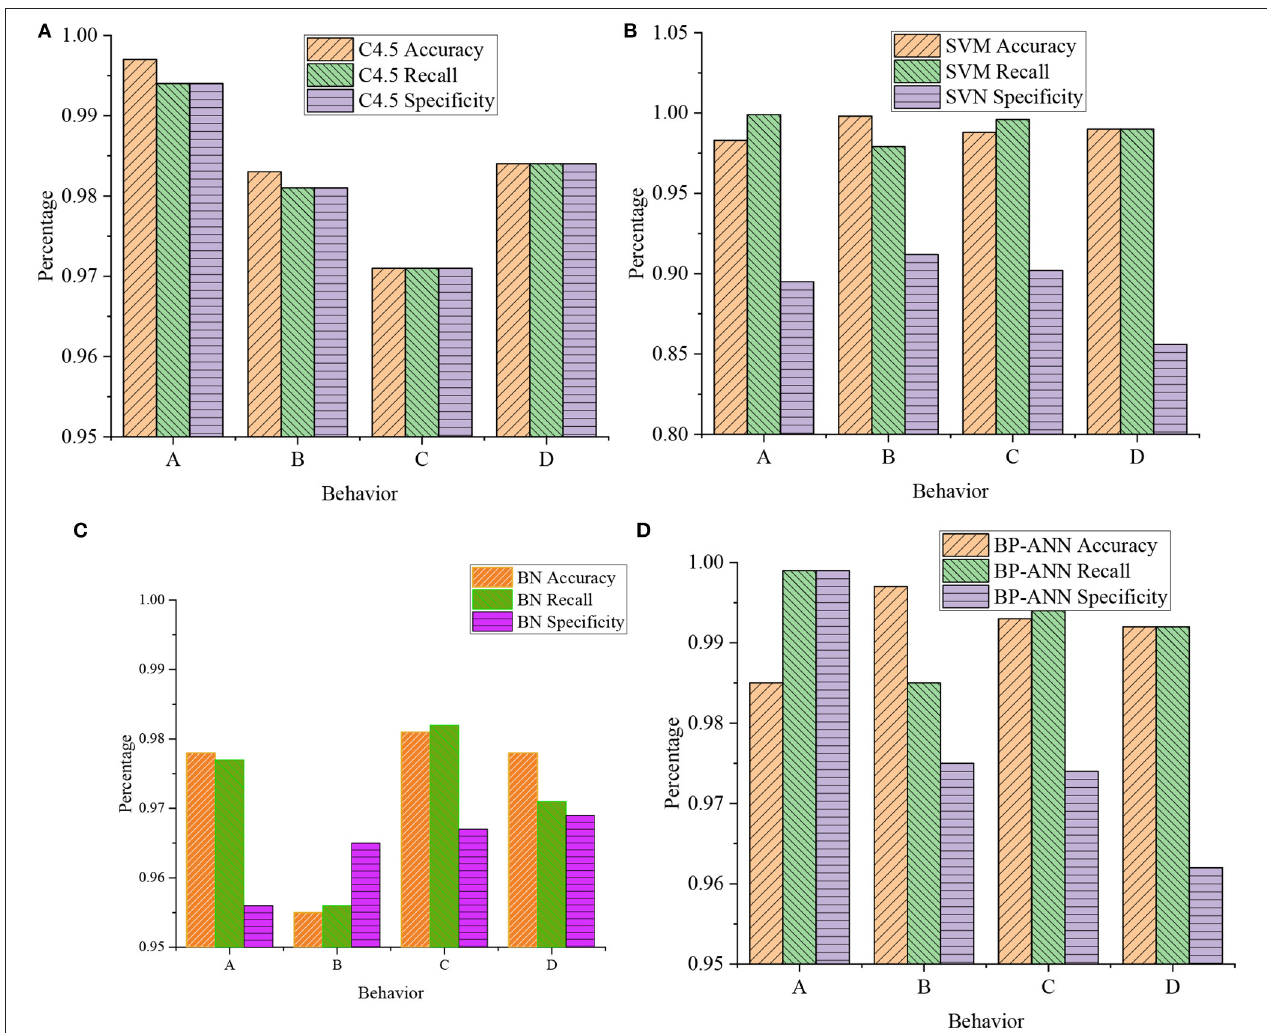
FIGURE 10 | Classification results of lower limb movements in basketball training by different classification algorithms (A: jumping; B: running; C: on foot; D: average level). (A) Accuracy and recall of C4.5; (B) accuracy and recall of SVM; (C) accuracy and recall of BN; and (D) accuracy and recall of BP-ANN.